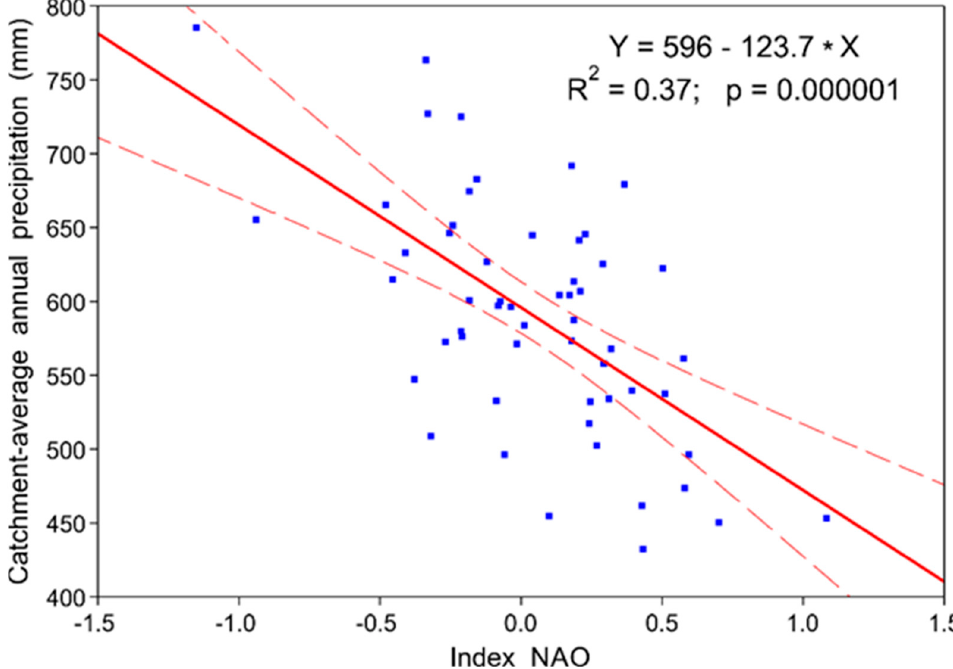
Figure 6. Scatter plot and estimated linear regression relationship between the average for annual precipitation totals at 9 stations from the upper and middle parts of the Odra River catchment and annual values of the NAO index during the years 1966–2020.